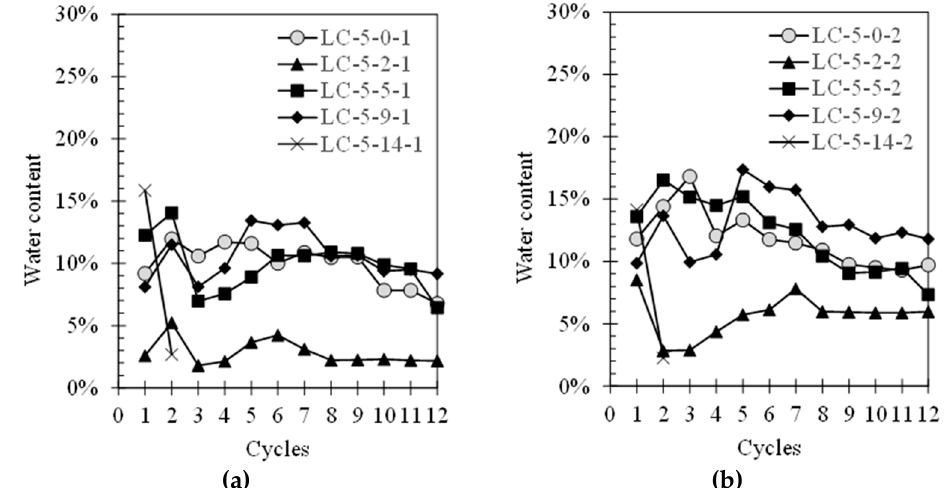
Figure 11. Water content alterations throughout the wetting–drying cycles: ( a ) volume and moisture change specimens, and ( b ) soil–cement loss specimens.